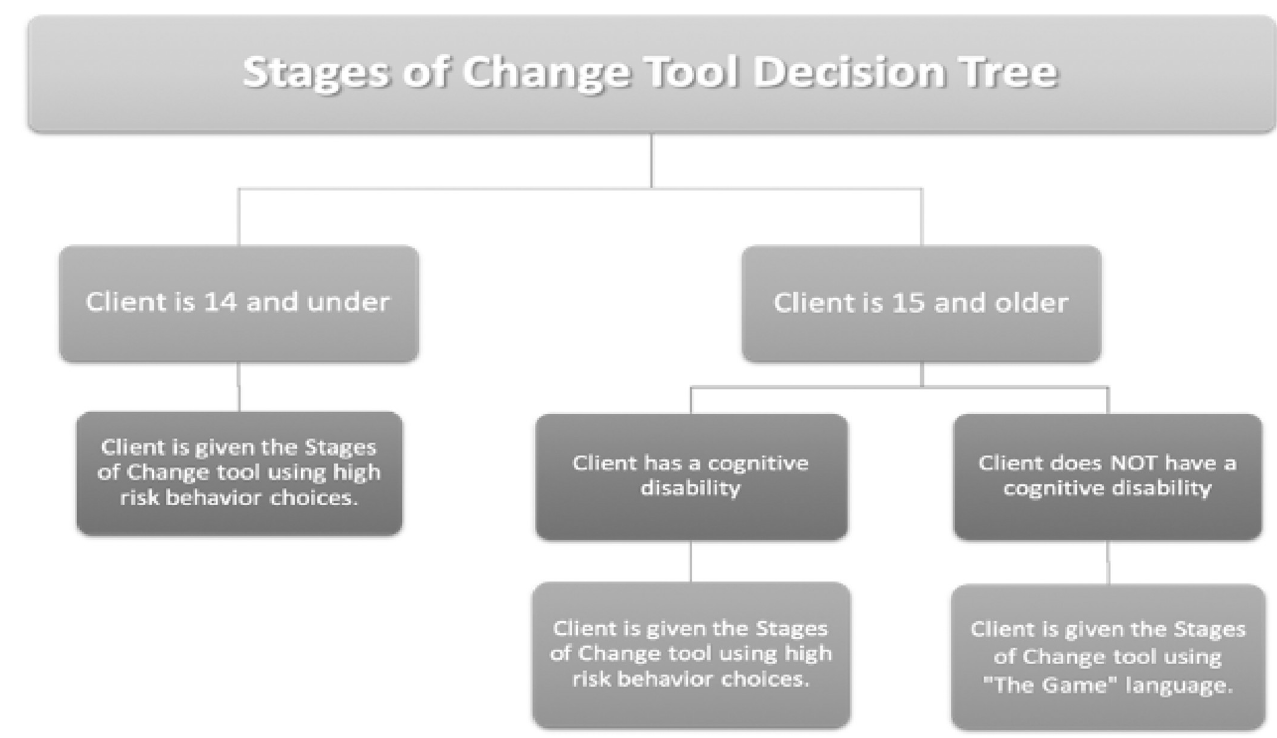
Fig 2. URICA decision tree. Agency’s protocol to select appropriate stages of change